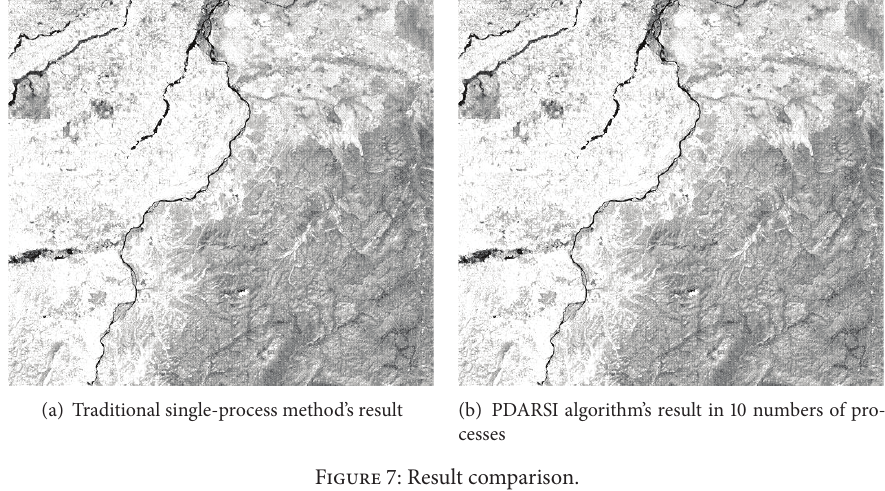
Figure 7: Result